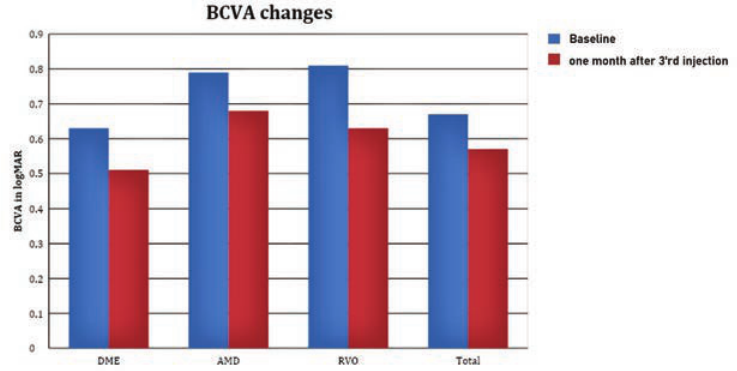
Figure 1. Mean BCVA (LogMAR) at baseline and one month after the third Stivant® injection. ( P -value = 0.12, 0.19, 0.05, and 0.10 in the DME, wet-type AMD, RVO, and in all patients, respectively).